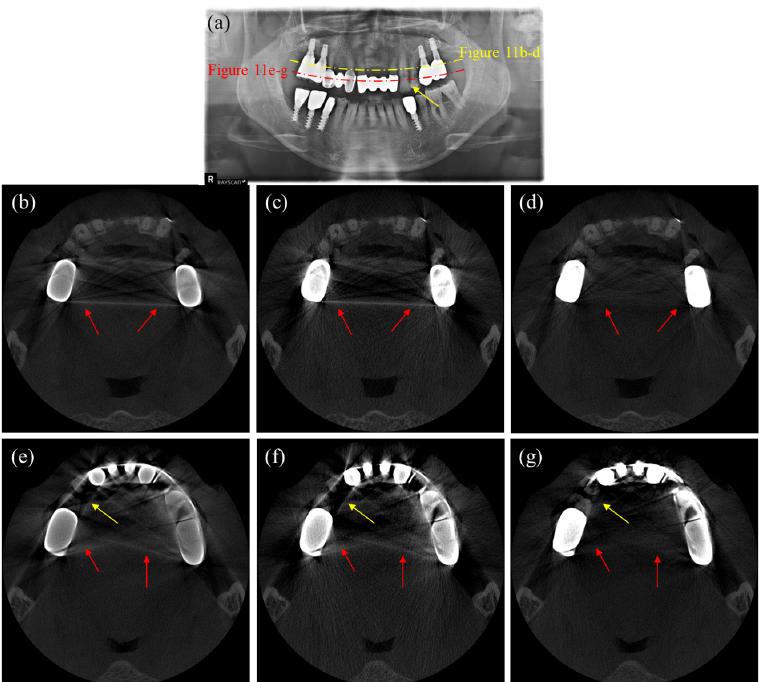
Figure 11. Images of a patient having multiple dental implants and crowns. ( a ) The panoramic X-ray image, ( b , e ) the uncorrected CT images, ( c , f ) the CT images corrected by the DSC method, and ( d , g ) the CT images corrected by the proposed method. (Contrast window is [ − 1117~8564] in Hounsfield Unit).